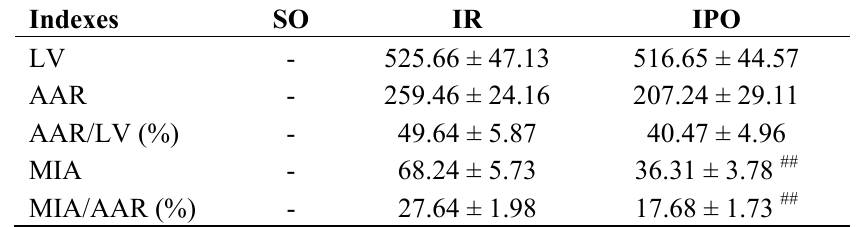
Table 3. Effect of ischemic postconditioning on the myocardium infarction in IR rats.